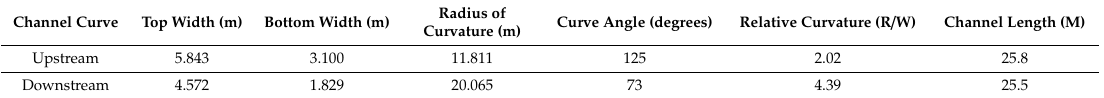
Table A3. Summary of CSU physical model dimensions [56].